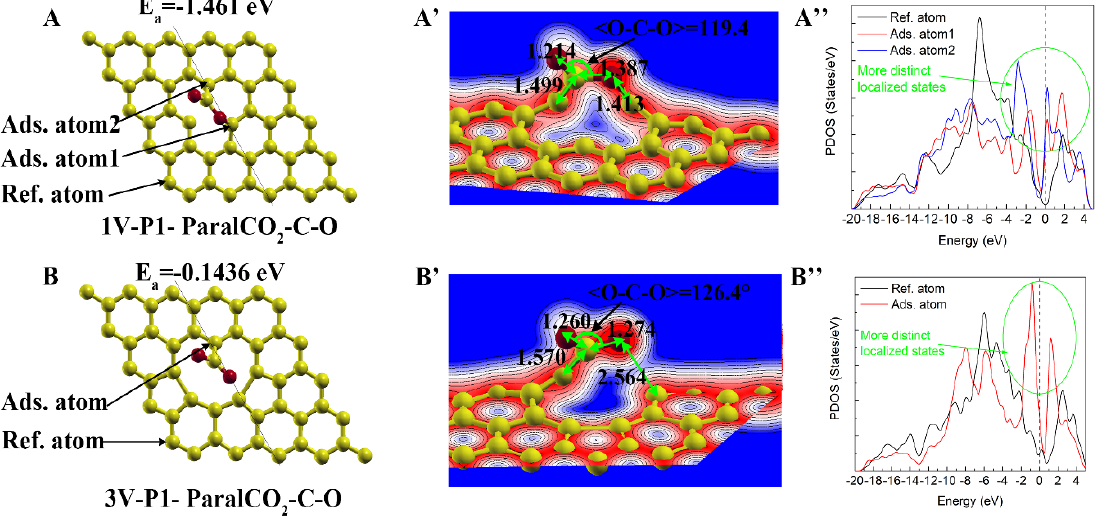
Figure 10. Energetically favorable chemisorption on carbon atoms with dangling bonds: ( A , A’ ) and ( B , B’ ) represent the atomic structure/charge distribution of adsorption on monovacancy (1V) and trivacancy (3V) defects, respectively. A is the result of 1V-P1-ParaalCO 2 -C-O, and B is the result of 4V-P2-ParaalCO 2 -C-O.